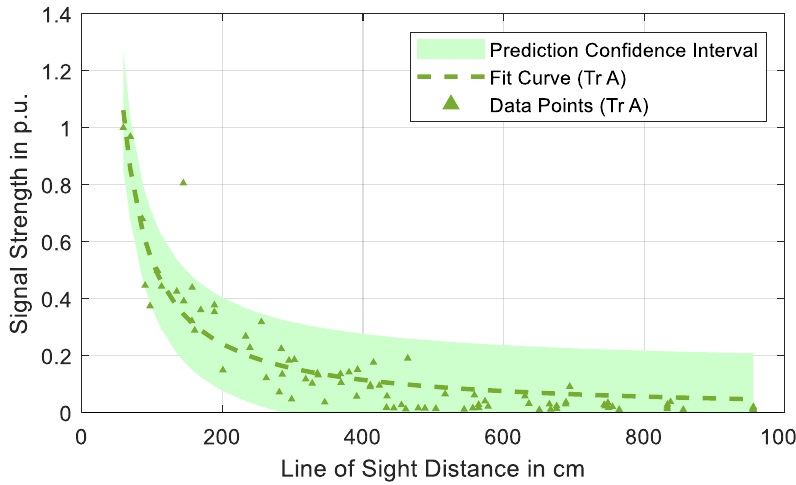
Figure 4. Signal attenuation in transformer A with the corresponding fit curve.